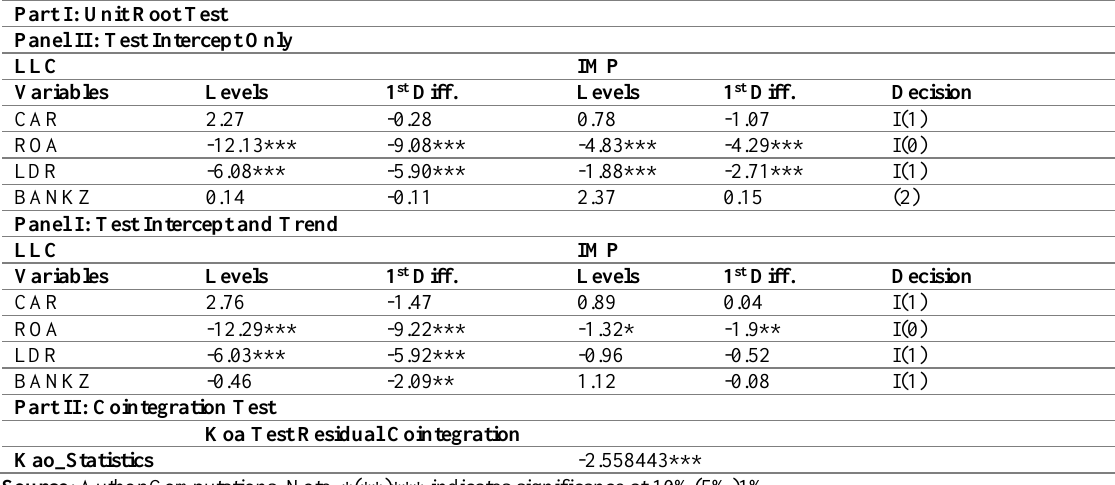
Table 3: Index Sustainability